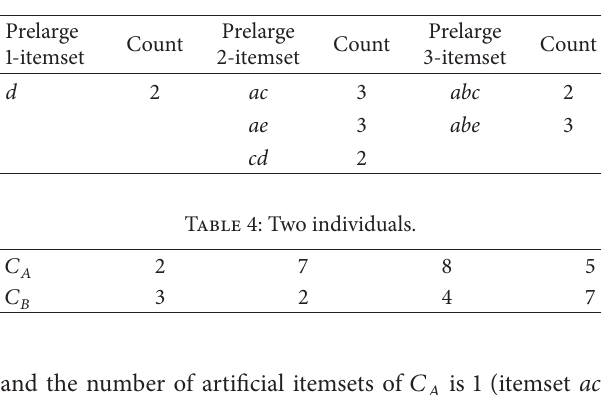
Table 3: Prelarge itemsets.